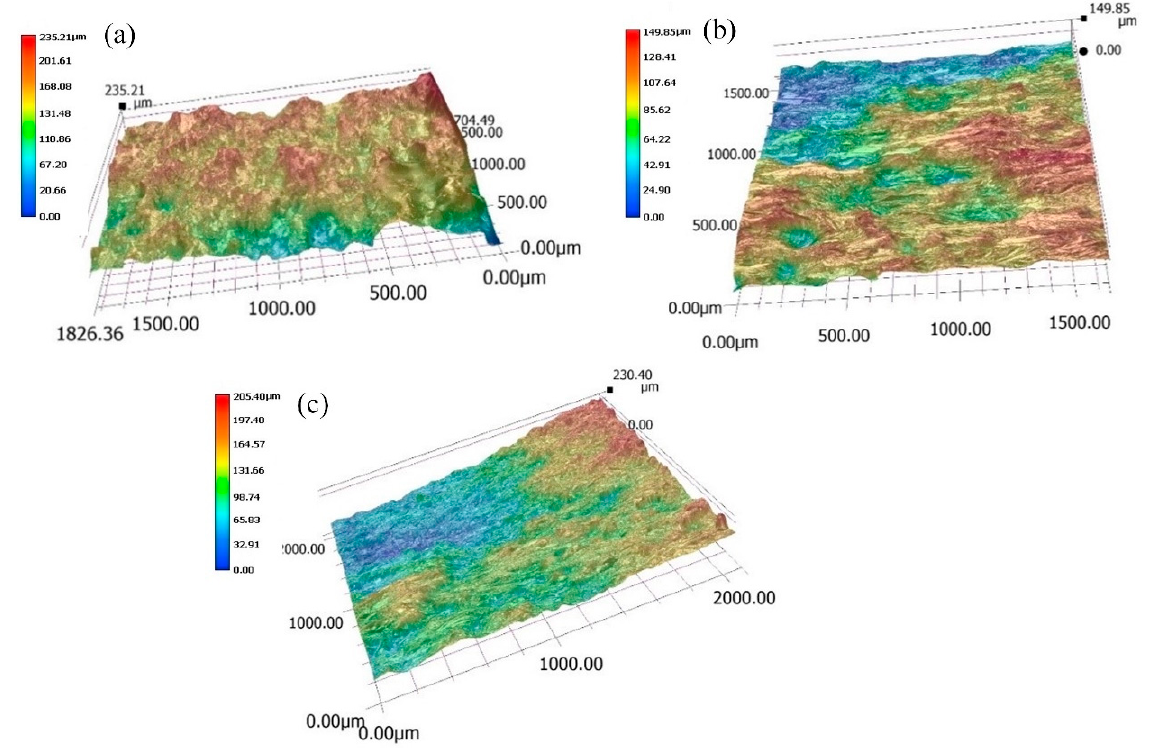
Figure 5. Three-dimensional (3D) morphology of the fatigue fracture surface of 2524-T3 aluminum alloy: ( a ) fatigue crack initiation zone; ( b ) crack propagation zone; ( c ) instantaneous failure zone.